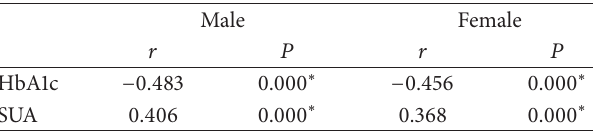
Table 2: Correlations between InsAUC120 and SUA as well as HbA1c in different